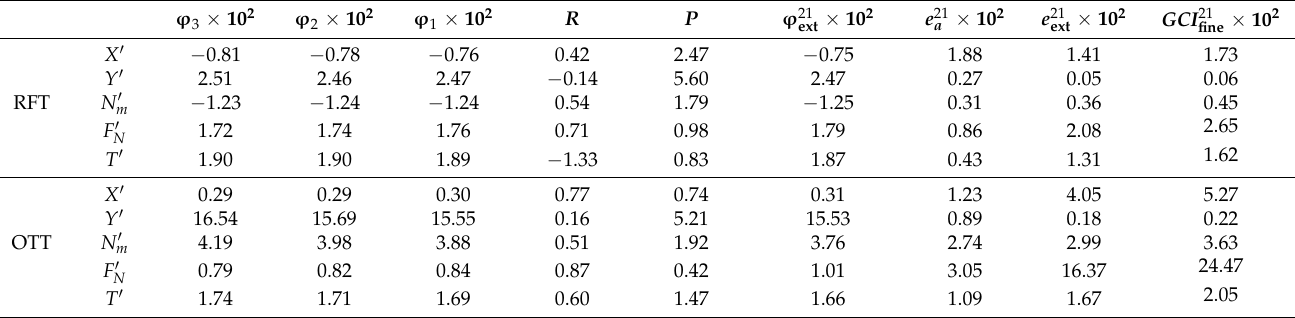
Table 4. The discretization error and uncertainty in spatial convergence study (SM method).